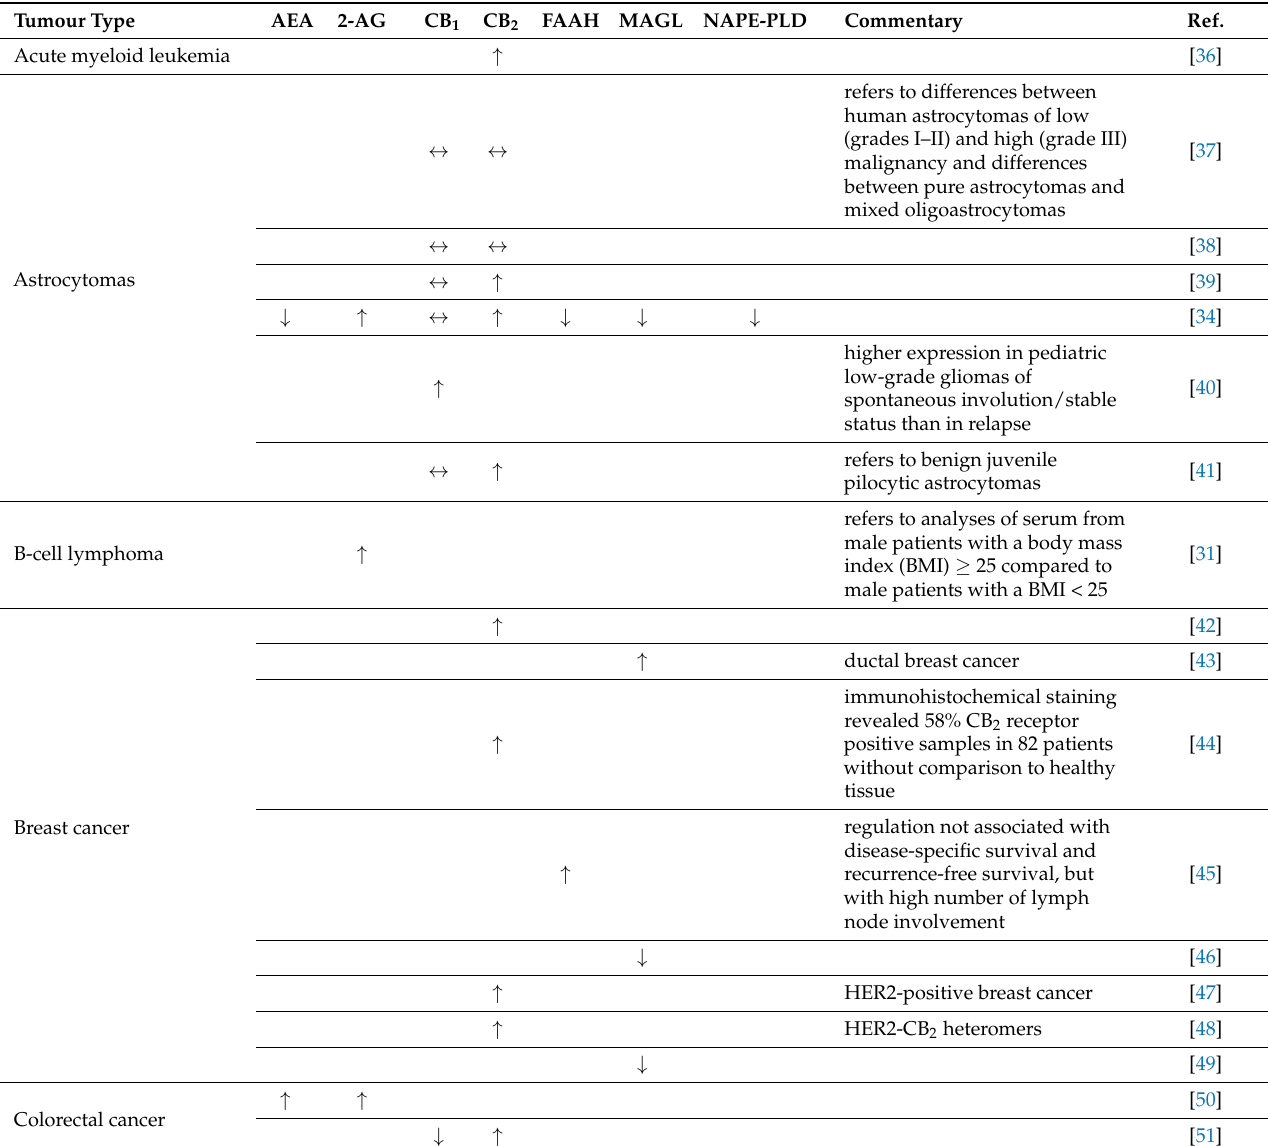
Table 1. Regulation of endocannabinoids, cannabinoid receptors, FAAH, MAGL and NAPE-PLD in tumour tissues (in a few labelled cases serum/plasma) from cancer